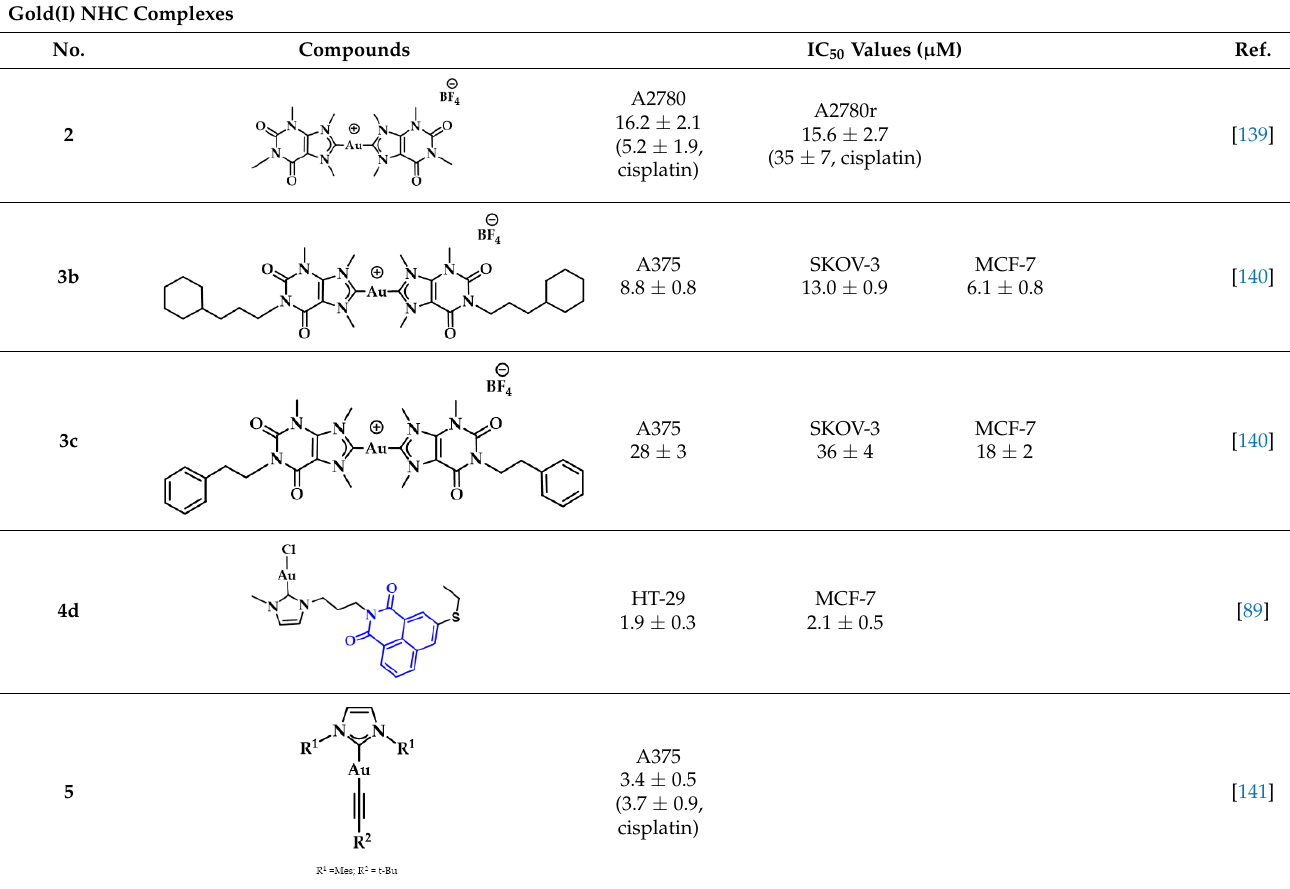
Table 2. Summary of IC 50 values of complexes.